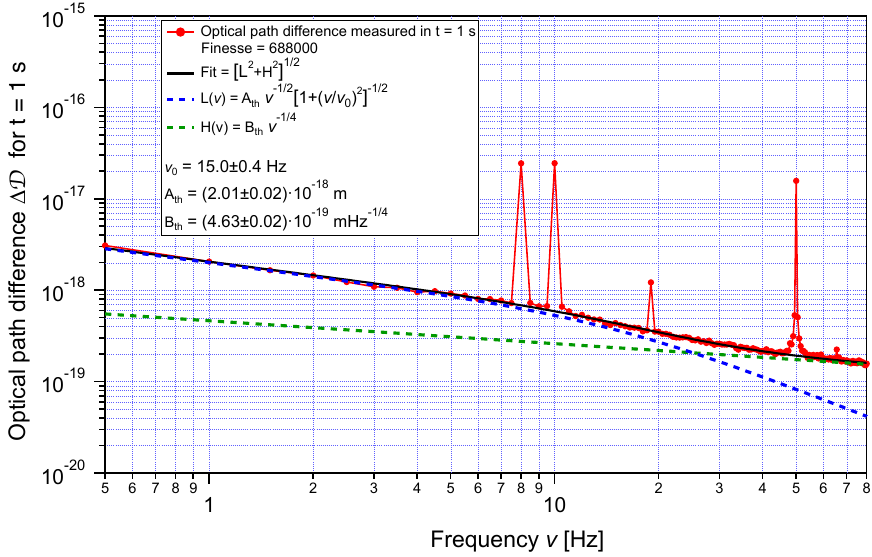
Figure 16. Optical path difference spectrum for F = 688,000 measured with the PVLAS-FE appa- ratus in t = 1 s with ( 850 ± 20 ) µ bar of Ar generating the two identical peaks at 8 Hz and 10 Hz. Superimposed is the fit obtained using Equation (58). The dashed lines are the two contributions to the curve describing the